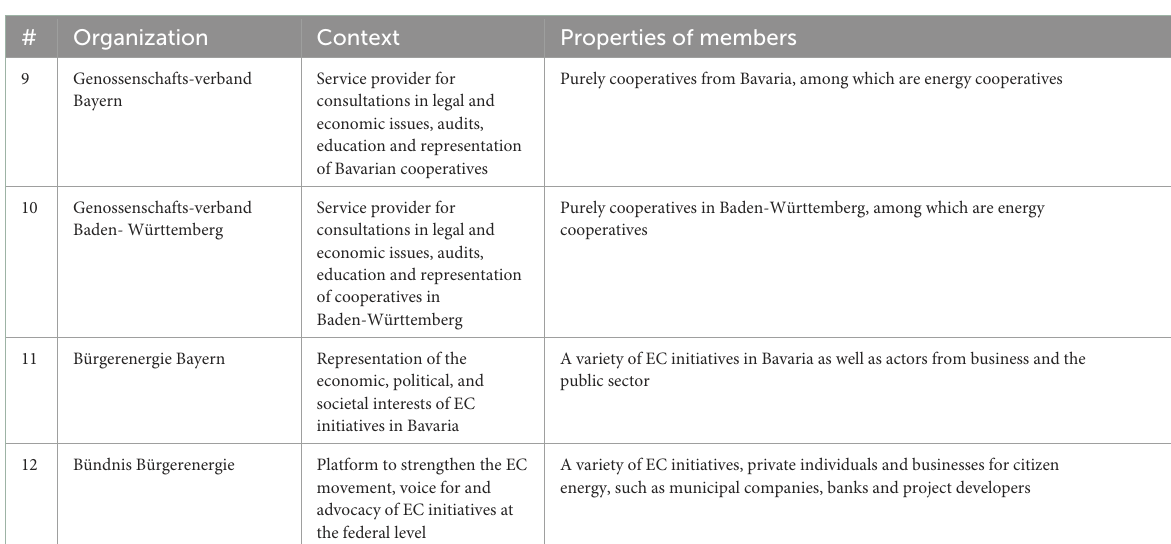
TABLE 2 The interviewed umbrella organizations